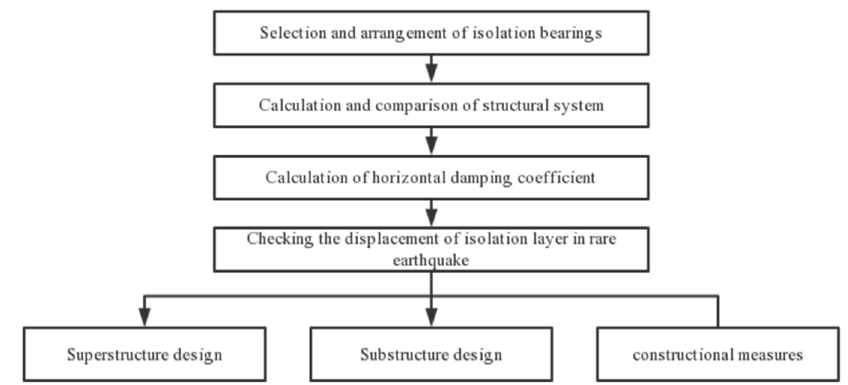
Figure 15. Design steps of isolated structure.